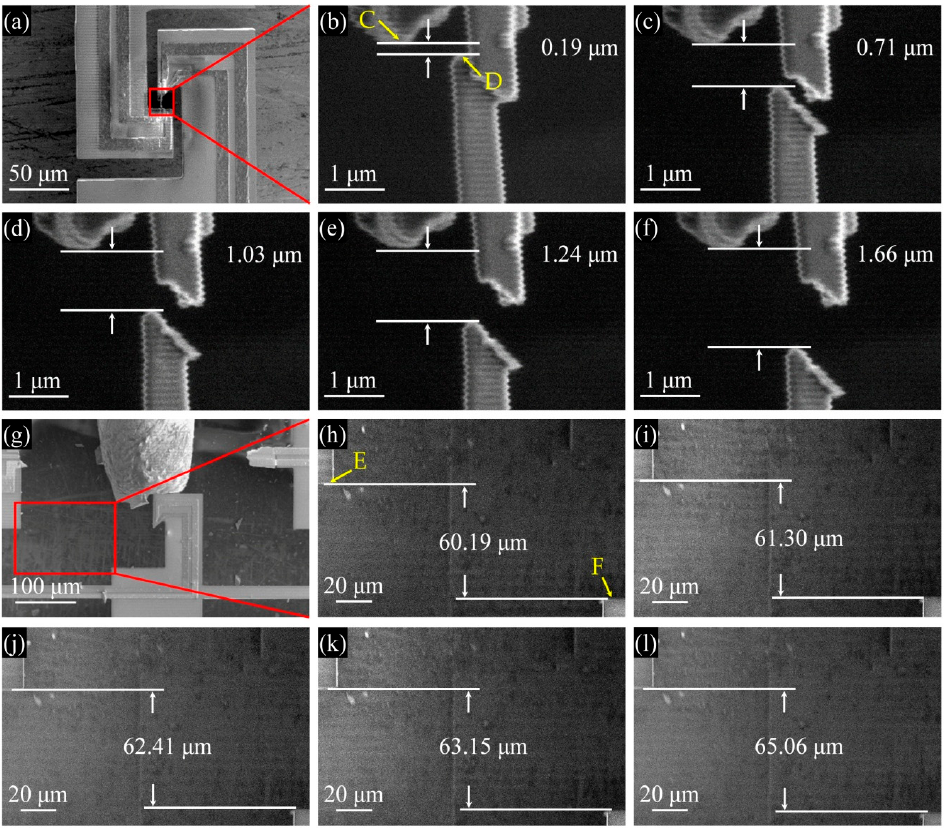
Figure 11. Displacement calibrations of sensors in SEM: ( a – f ) the displacements of the two reference points for sensor A; and ( g – l ) their displacements for sensor B.